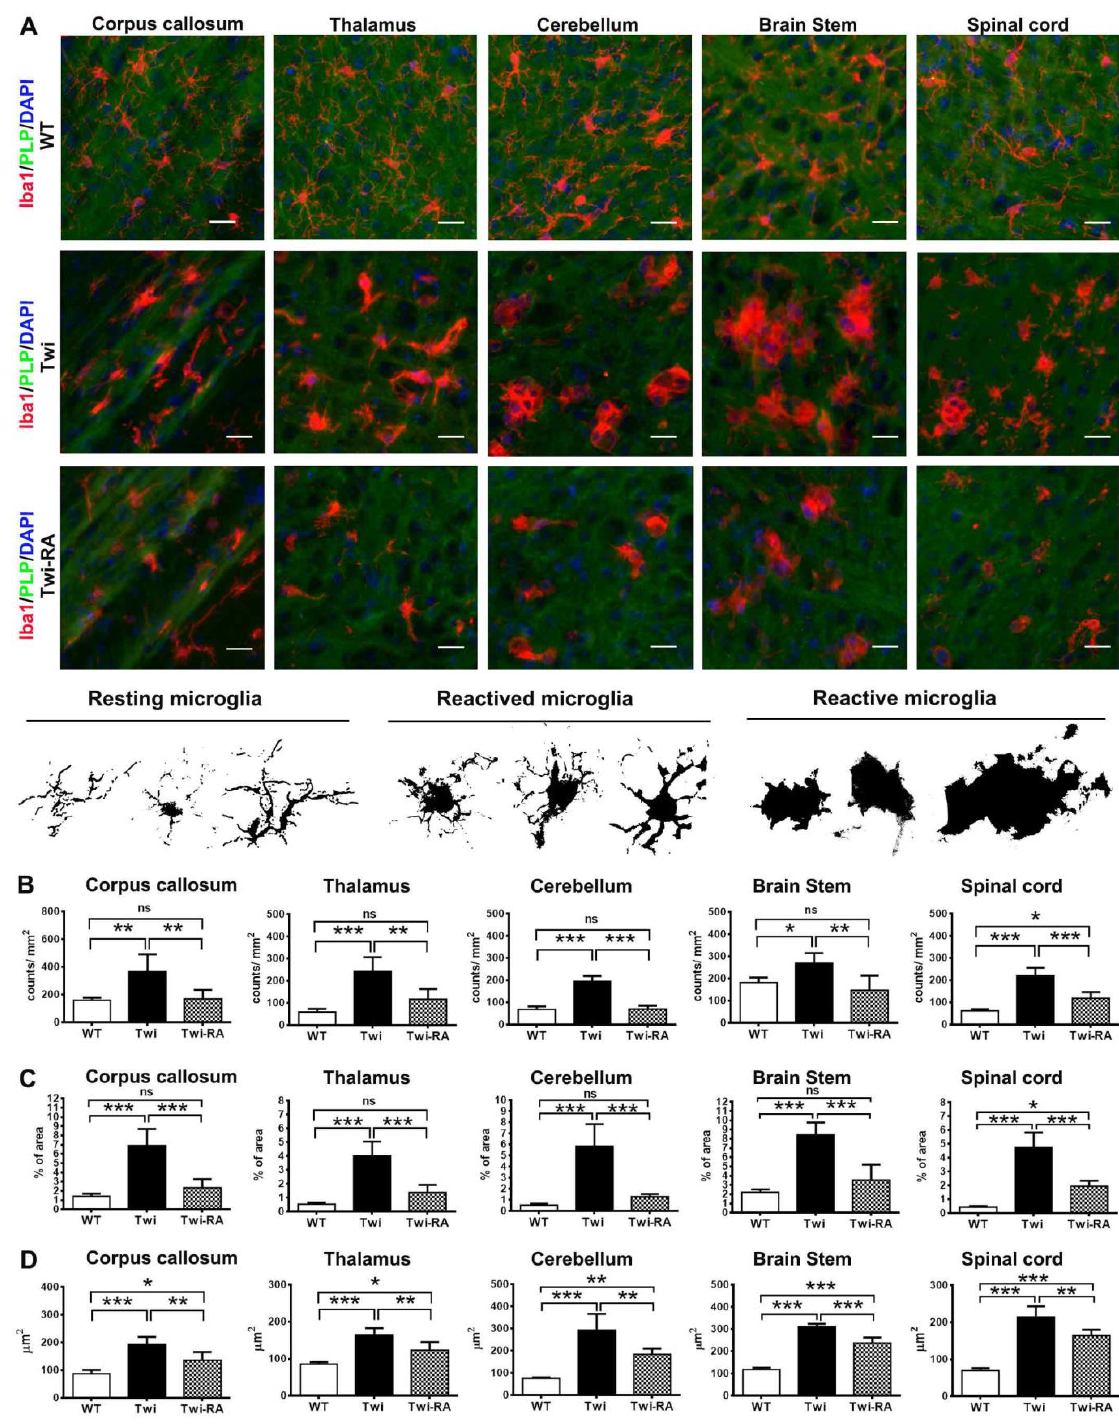
Figure 6. Amelioration of microglia activation by rapamycin. ( A ) Representative images of distribution of microglia in different regions of the wild-type (WT), untreated twitcher (Twi), and rapamycin-treated twitcher (Twi-RA) mice brain at ages 35 days. The brain was immuno-stained with anti-Iba1 (in red) and anti-PLP (in green), respectively, and nuclei were counterstained with DAPI (in blue). Scale bar: 25 µ m. ( B ) Representative images of microglia activation phenotype. Total amounts of microglia per square millimeters ( B ), the percentage of area occupied by microglia ( C ), and the average size of microglia ( D ) were quantitatively analyzed with ImageJ. Values are expressed as mean ± SEM and compared using One way ANOVA (Tukey post hoc test) ( n = 5). Statistical significance, * p < 0.05, ** p < 0.01, *** p < 0.001, and ns (not